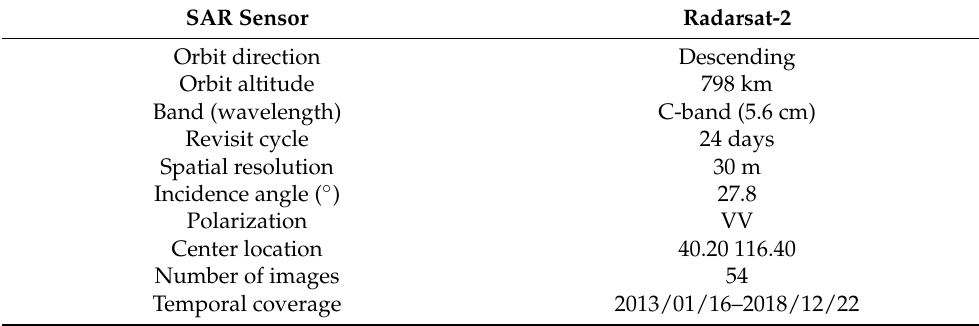
Table 1. Acquisition parameters of Radarsat-2 data